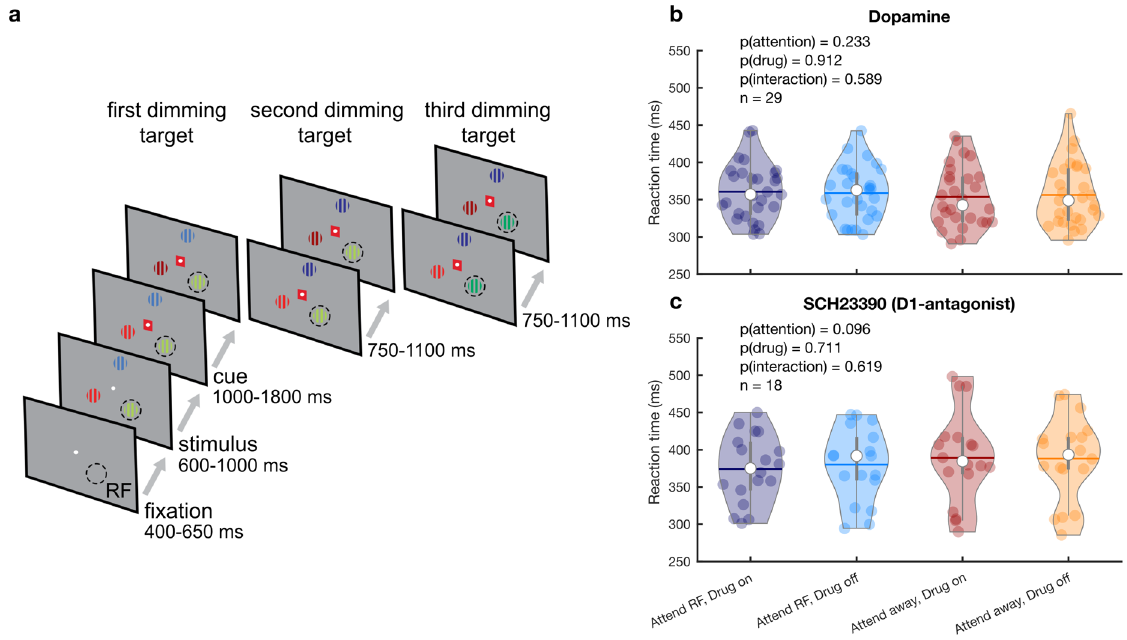
Figure 1. Paradigm and behavioral performance. ( a ) Behavioral paradigm. The monkey held a lever and fixated on a central fixation spot to initiate the trial. One of three colored gratings was presented inside the receptive field (RF) of the neurons under study. After a variable delay a cue matching one of the grating colors surrounded the fixation spot, indicating which grating was behaviorally relevant (target). In pseudorandom order the stimuli decreased in luminance (dimmed). Upon dimming of the target, the monkey had to release the lever to obtain a reward. ( b, c ) Average RT on attend RF and attend away trials for the non-specific agonist dopamine ( b ) and the D1R antagonist SCH23390 ( c ). Individual markers represent the average RT during a single recording session. Error bars denote the interquartile range. Horizontal bars denote the mean. Statistics: linear mixed-effects model